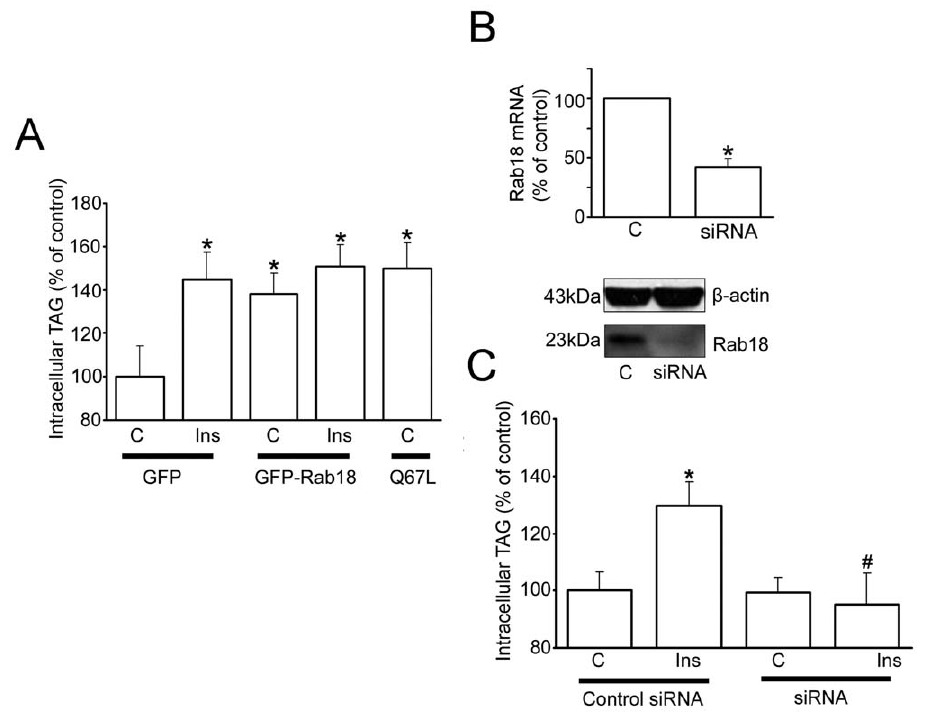
Figure 6. Effect of Rab18 overexpression and silencing on insulin-induced lipogenesis. (A) The effect of Rab18 overexpression on basal and insulin-induced lipogenic activity in 3T3-L1 adipocytes was assessed by transfecting cells with GFP-tagged versions of wild-type Rab18 or the constitutively active mutant Rab18(Q67L) for 48–72 h. In parallel, a group of cells (controls) were transfected a vector expressing GFP alone. GFP fluorescence served to confirm transfection efficiencies higher than 90% for each experiment prior to further experimental manipulation. After 4-h treatment, cells were lysed and intracellular TAG content was quantified. TAG content was normalized to total protein content and expressed as the mean 6 SEMof 6 independent experiments. (B)Rab18 silencingwas achieved by transfecting3T3-L1 cells with a mouse Rab18 specific siRNA.As control, a group of cells were transfected with a scramble negative control siRNA. Rab18 knock down was confirmed by quantitative RT-PCR and Western blot. (C) After 72 h, cells were challenged to 100 nM insulin for 4 h, harvested and lysed. TAG was content quantified as indicated above and expressed as the